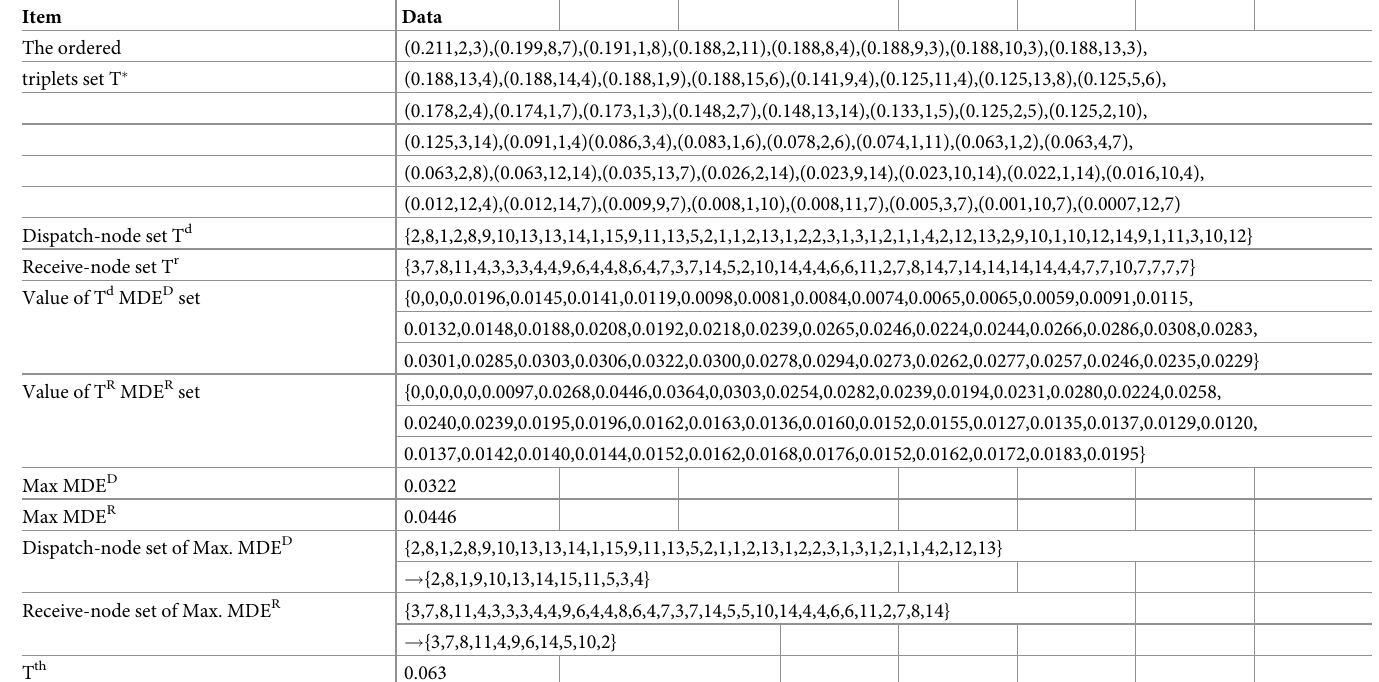
Table 3. Threshold results by MMDE.